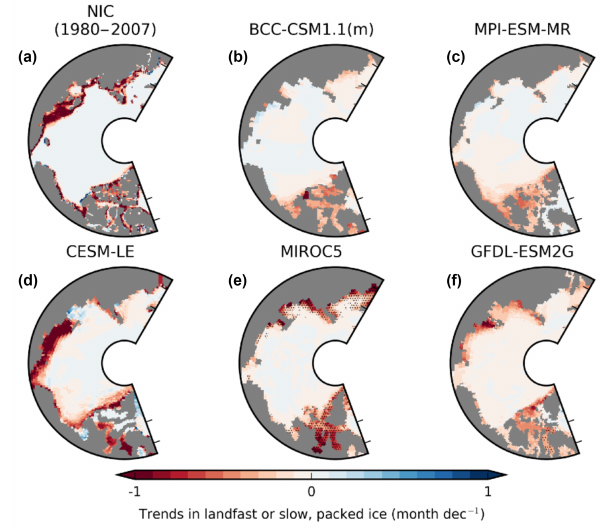
Figure 5. (a) Same as Fig. 5. (b) – (f) Same as (a) but for the models in Fig. 3b–f over the period